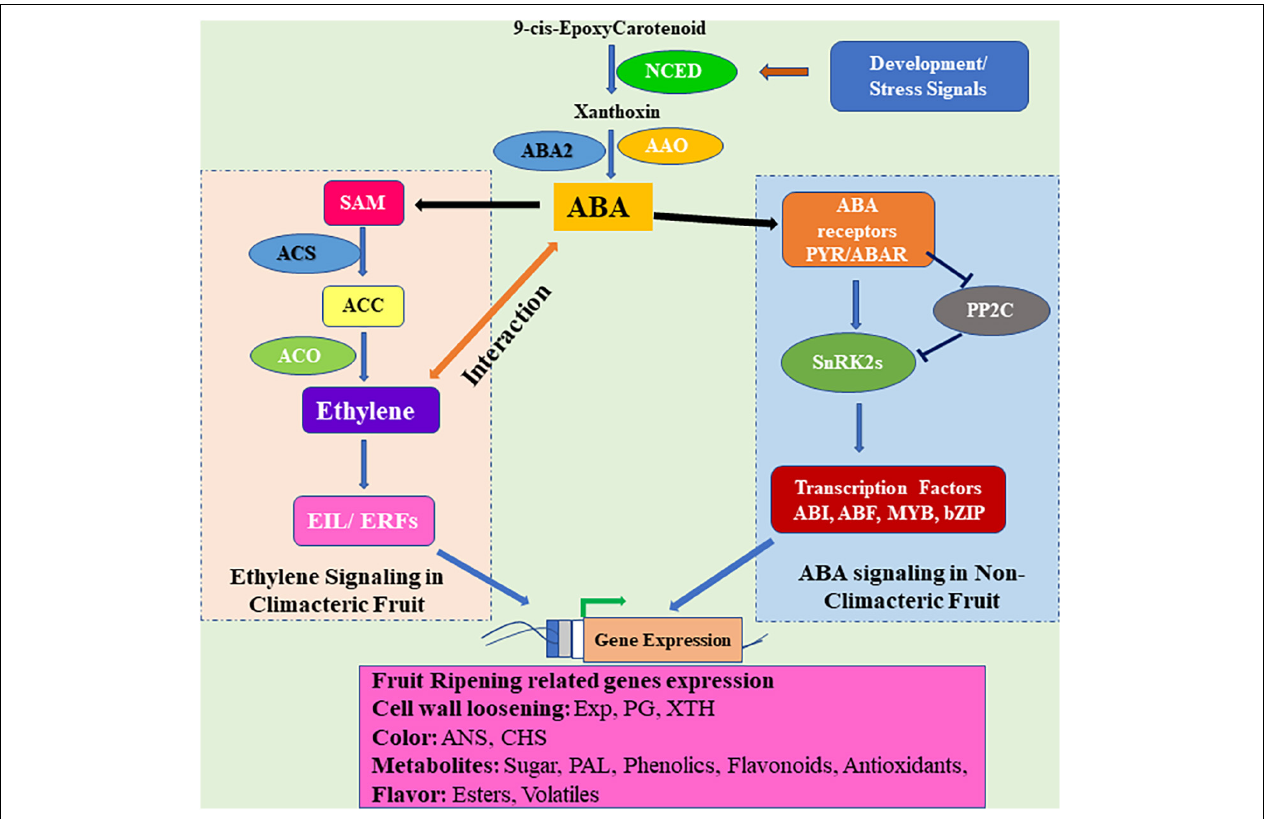
FIGURE 3 | Abscisic acid and ethylene signaling in the regulation of fruit ripening. In climacteric fruits, ABA cross-talks with ethylene and regulates ethylene synthesis. ABA signal is perceived by the PYR1–PP2C–SnRK2 module which regulates the phosphorylation of ABA-responsive transcription factors (TFs) and induces the expression of genes related to development and ripening in non-climacteric fruits. Ethylene synthesis is catalyzed from SAM by ACS and ACO enzymes. Ethylene binding activates EIN3/Ethylene Insensitive3-Like (EIL) transcription factors, which can activate the expression of ethylene response factor (ERF) TFs. ERFs modulate the ethylene-regulated genes by binding to their promoters. ACC: 1-aminocycloproane 1-carboxylic acid, ACS: ACC synthase, ACO: ACC Oxidase, SAM: S-adenosyl methionine, PYR: Pyrabactin Resistance, PP2C: Type 2C protein phosphatases, SnRK2C: SNF1-related protein kinases 2, EXP: Expansins, PG: Polygalacturonase, XTH: Xyloglucan hydroxylase, NCED:, AAO:, ABA2: ANS: Anthocyanin synthase, CHS: Chalcone synthase, ABI: ABA insensitive, ABF: ABA-response element binding